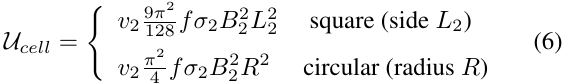
Figure 3: EC distribution in heterogeneous and homoge- neous material for the plate presented in Fig. 1. mogenized material, even though they have completely dif- ferent EC distributions.